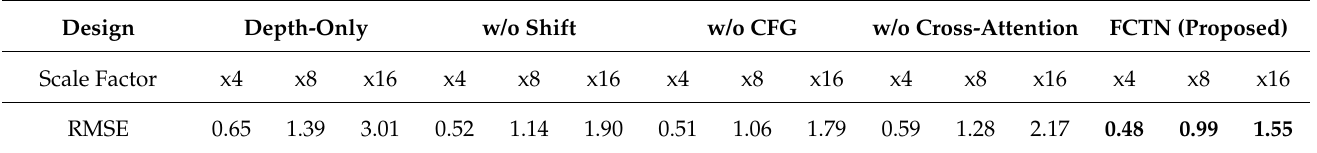
Table 6. An analysis of the average RMSE values for different ablation experiments on the noise-free Middlebury dataset. Boldface indicates the best RMSE for each